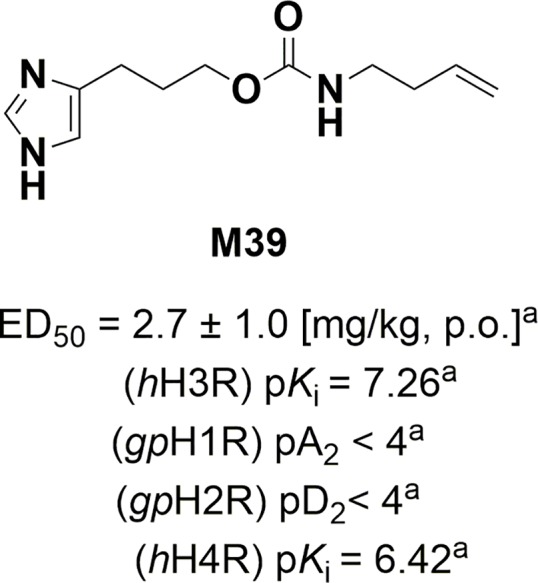
Structure, in-vivo potency, and in-vitro antagonist affinities of H3R antagonist/inverse M39. aValues previously published (Wiecek et al., 2011; Sadek et al., 2013). Values for H1R and H2R were tested on guinea pig (gp).